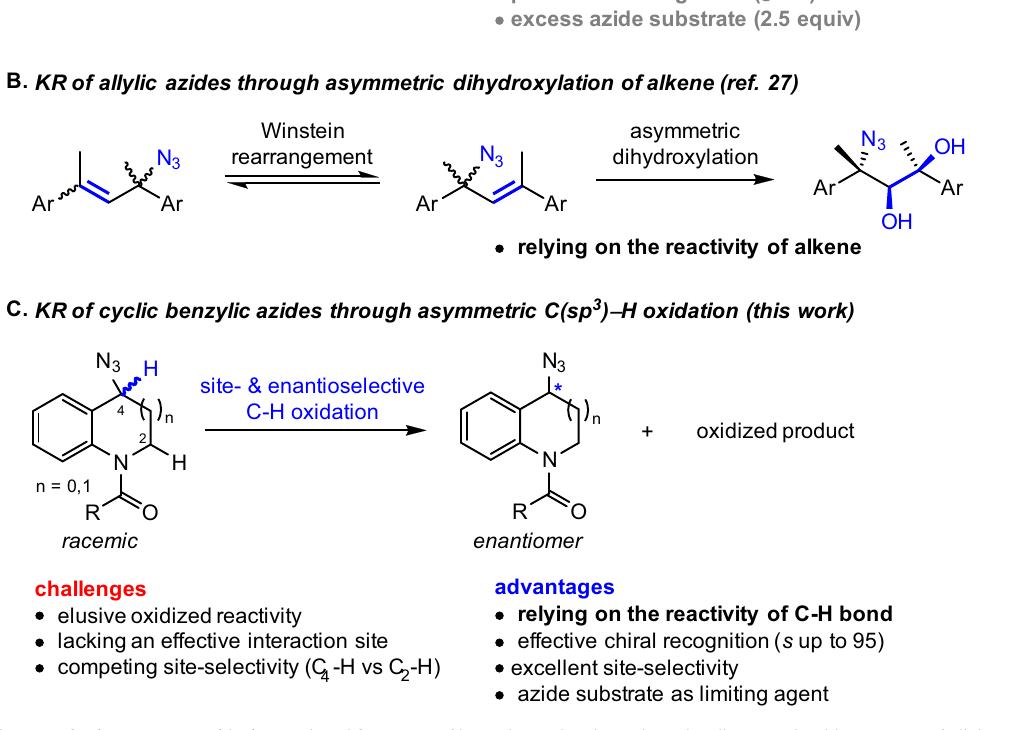
Fig. 1 Overview of KR methods to prepare chiral organic azides. A KR of benzylic azides through azide – alkyne cycloaddition. B KR of allylic azides through asymmetric dihydroxylation of alkene. C KR of cyclic benzylic azides through asymmetric C(sp 3 ) − H